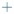
A principal component analysis of miRNA expression levels in duodenal biopsies can classify with NCWS and CD.(A) A principal component analysis was performed on the ΔCt values for each gene. First component (PC1) was plotted against second component (PC2) to identify genes driving the two components and to explain the percentage variation. + NCWS group; ◦ CD group. (B) Fitted ROC curve (blue line) of the first principal component data (red dots). Plotting of the true positive rate versus false positive rate as defined by the PC1 values. AUC = 0.76 ± 0.0680 (p<0.001, Wilcoxon U test). Grey lines: 95% confidence interval of the fitted ROC curve.